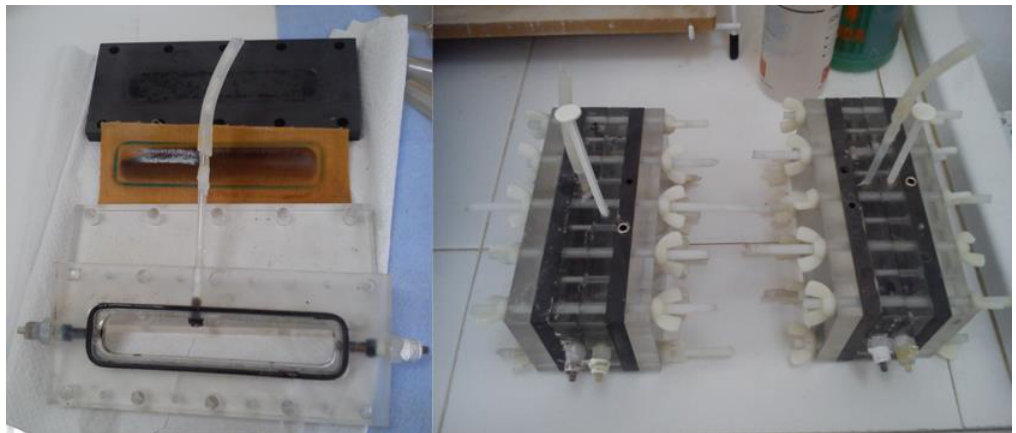
Figure 1. MFC picture. Grafite electrode (black); cation exchange membrane (yellow), and framework